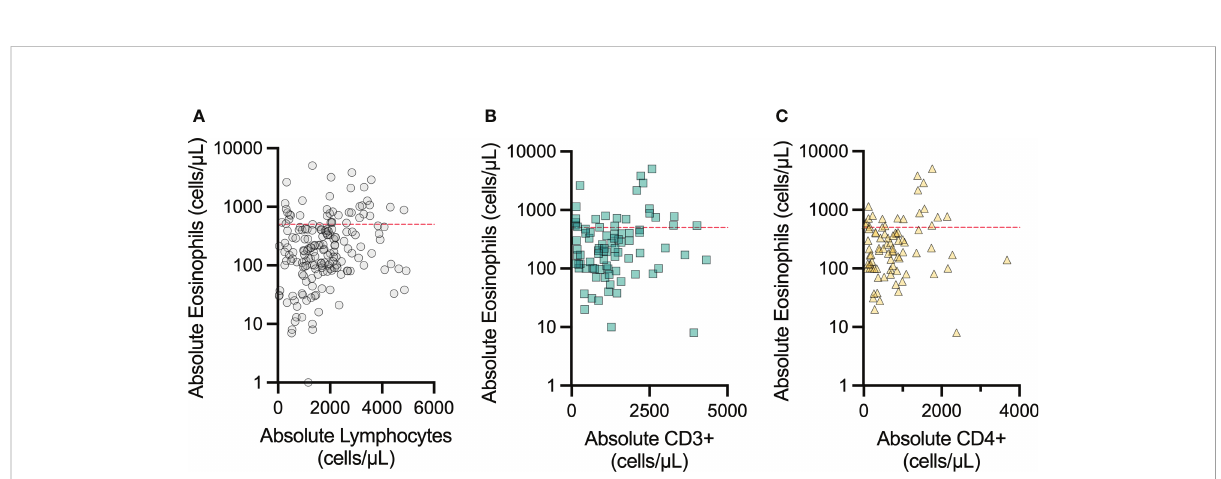
FIGURE 4 Peripheral eosinophil count does not vary with peripheral lymphocyte count in patients with concomitant IEI and eosinophilic GI disorders. The correlations between peripheral blood absolute eosinophil count and (A) peripheral blood absolute lymphocyte count, (B) peripheral blood absolute CD3+ count, and (C) peripheral blood absolute CD4+ count were not signi fi cant. The red dashed line indicates 500 eosinophils per microliter, which is clinically considered the initial cutoff for eosinophilia.